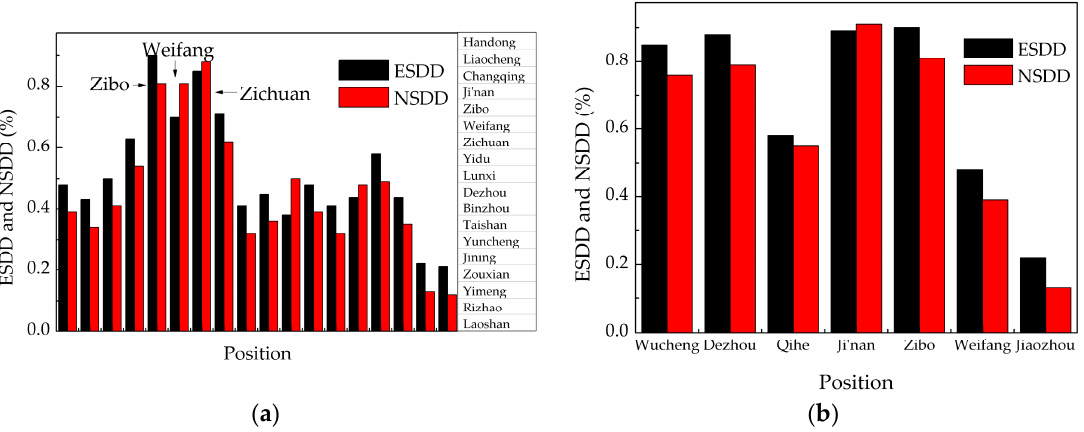
Figure 6. Sampling results in 2015 and 2016. ( a ) 500 kV. ( b ) ±660 kV. Energies 2017 , 10 , 1580